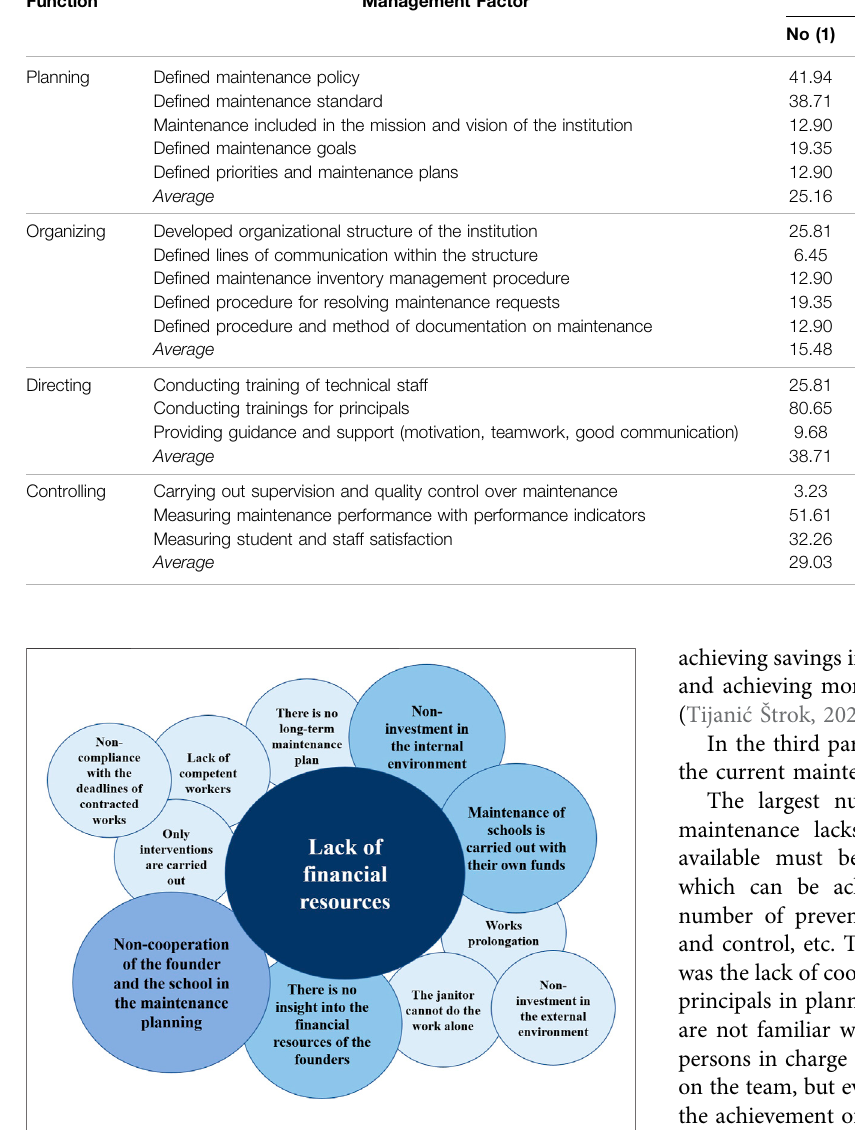
FIGURE 5 | Highlighted problems in the current schools ’ maintenance management process according to principals.